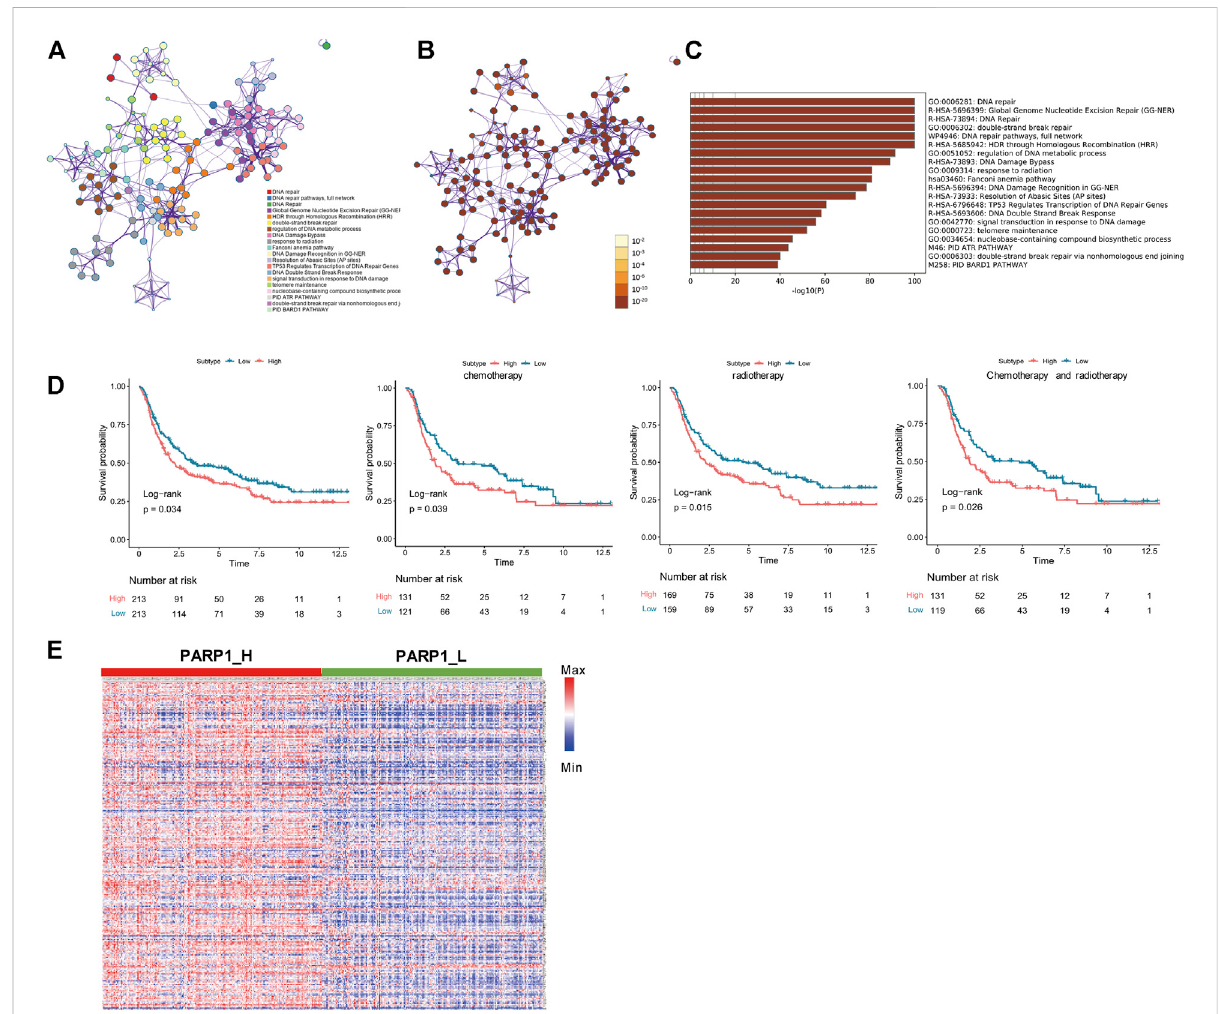
FIGURE 2 Functional enrichment analysis of 278 genes of the DNA-repair proteins, and analyses between PARP1_L ( n = 213) and PARP1_L ( n = 213) from GEOdatabase. (A) EnrichedtermsarecoloredbyclusterID,wherenodesthatsharethesameclusterIDaretypicallyclosetoeachotherin278genes of the DNA-repair proteins. (B) Enriched terms are colored by p -value, where terms containing more genes have a more signi fi cant p -value in 278 genes of the DNA-repair proteins. (C) Heatmap of enriched terms across input gene lists, colored by p -values. (D) Comparison of survival prognosis between PARP1_H and PARP1_L, between PARP1_H and PARP1_L after chemotherapy, between PARP1_H and PARP1_L after radiotherapy, and between PARP1_H and PARP1_L after chemotherapy and radiotherapy from GEO using theLog-Rank test. (E) expression levels of the 278 genes of the DNA-repair proteins were compared between PARP1_H and